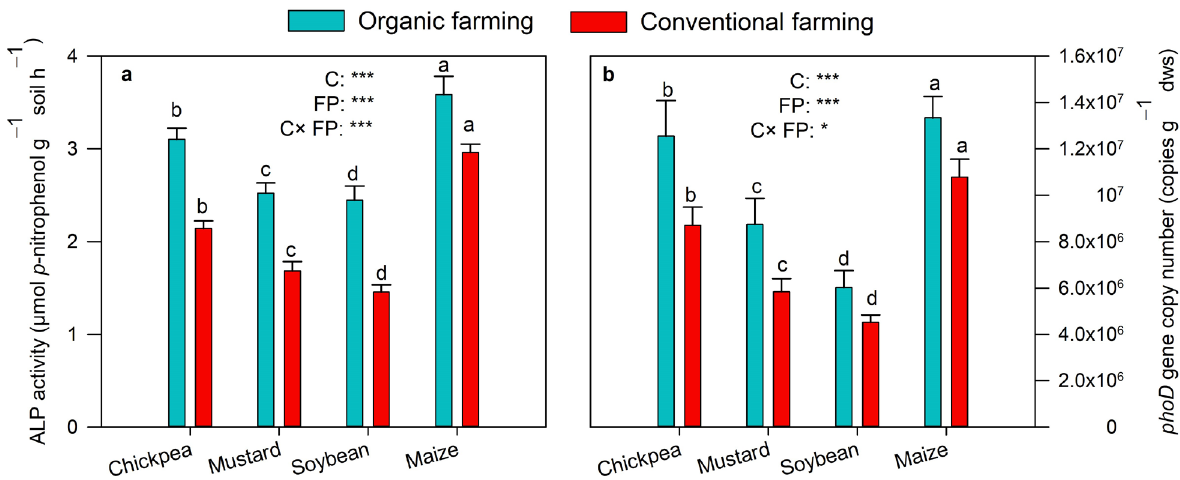
Figure 2. ALP activity ( a ) and phoD gene copy number ( b ) in organic and conventional farming. Different lower cases indicate significant differences (Tukey’s post hoc test) between crops in the same farming practice ( p < 0.05). The crops (C) and farming practice (FP) specify the results of MANOVA indicating p -value at different significance levels (* p < 0.05, *** p < 0.001). The values are two-year average mean ± SD. MBP, microbial biomass P; ALP, alkaline phosphatase.